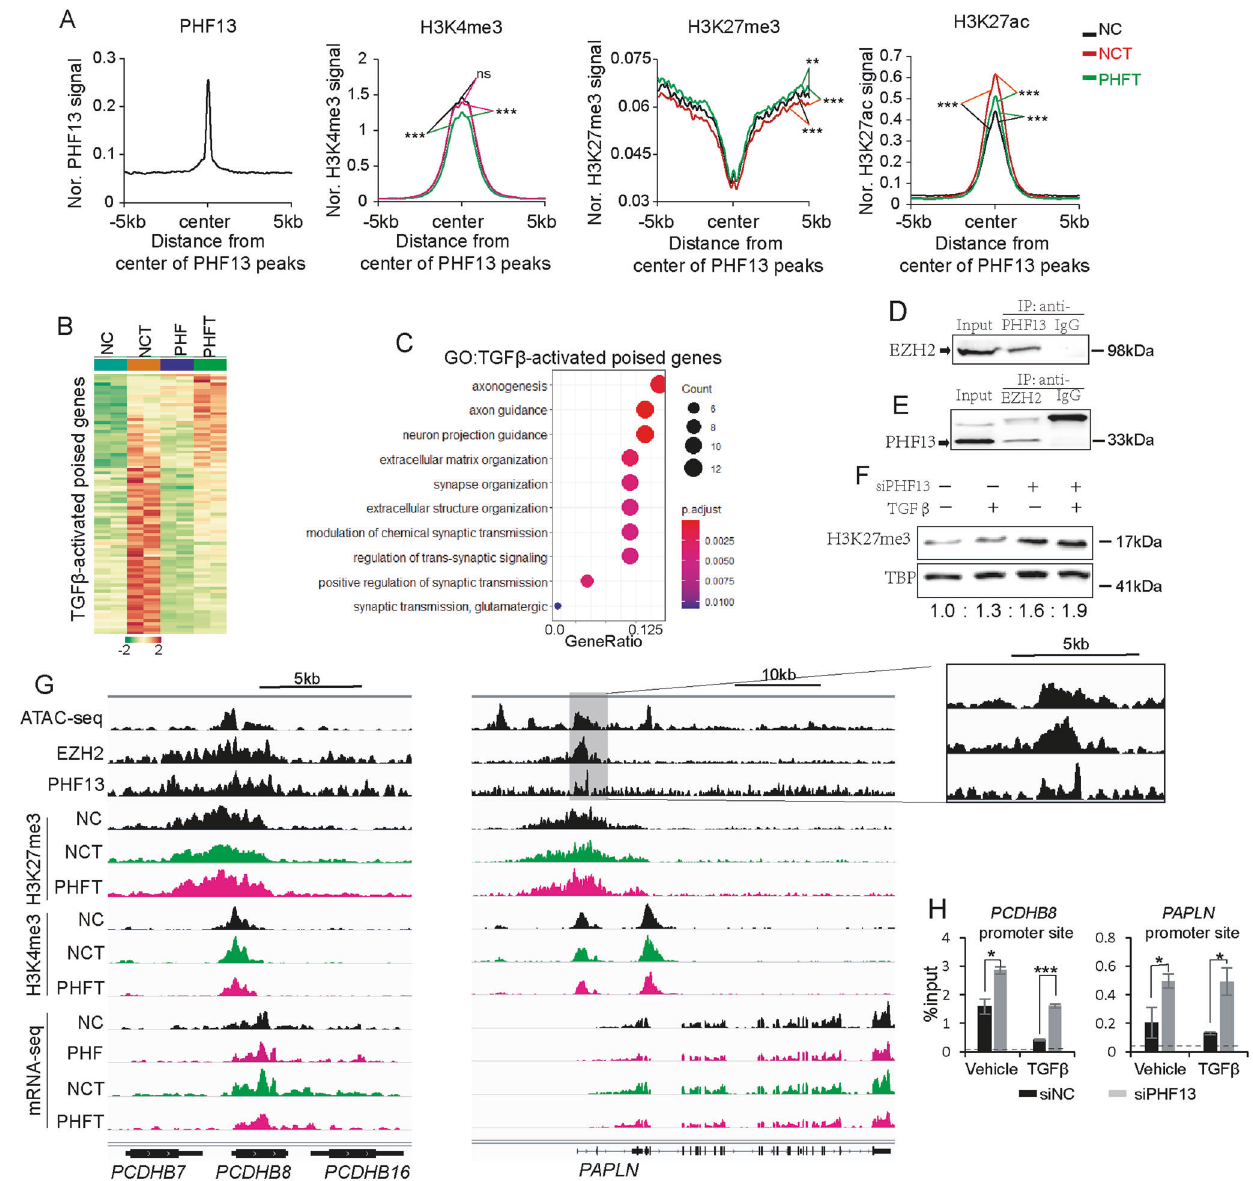
Fig. 5 The expression of TGF β -stimulated poised genes is highly dependent on PHF13. A Aggregate pro fi les show the occupancy of H3K4me3, H3K27me3, and H3K27ac surrounding the center of PHF13-occupied poised chromatin regions (±5 kb) in siNC, siNC + TGF β (NCT), and siPHF13 + TGF β (PHFT) Panc-1 cells. P values were calculated by Wilcoxon – Mann – Whitney Test. ns nonsigni fi cant difference; **0.01 < p < 0.001; *** p < 0.001. B Heatmaps show gene expression of TGF β -activated poised genes in siNC (NC), siPHF13 (PHF), siNC + TGF β (NCT), and siPHF13 + TGF β (PHFT) Panc1 cells. The color scale bar shows the row-wise normalized expression signal. C GO analysis of the TGF β -activated poised genes. The top 10 signi fi cantly enriched gene terms were shown. Western blot analysis of nuclear extract inputs, anti-PHF13 IP ( D ), anti- EZH2 IP ( E ), and anti-IgG IP from Panc1 nuclear extract. F Western blot showing the level of H3K27me3 in the given samples. The protein TBP was set as a loading control. The down numbers indicated the normalized signal of H3K27me3. The signal of each band was measured using ImageJ. The signal of H3K27me3 was normalized to TBP and represented as fold change relative to the control cells. G Genome browser tracks the normalized signal of chromatin assembly (ATAC-seq), EZH2, PHF13, H3K27me3, H3K4me3 occupancy, and mRNA-seq data at PCDHB8 an d PAPLN lo cus from siNC (NC), siPHF13 (PHF), siNC + TGF β (NCT), siPHF13 + TGF β (PHFT) Panc1 cells. H ChIP-qPCR analysis of H3K27me3 occupancy near the TSS of the PCDHB8 and PAPLN genes in siControl treated, PHF13-depleted, TGF β -treated, and PHF13-depleted TGF β -treated Panc-1 cells. p value was calculated using a two-side t test. * p < 0.05; *** p < 0.001. ChIP-qPCR for IgG was set as a negative control. The dotted line indicated the average signal of